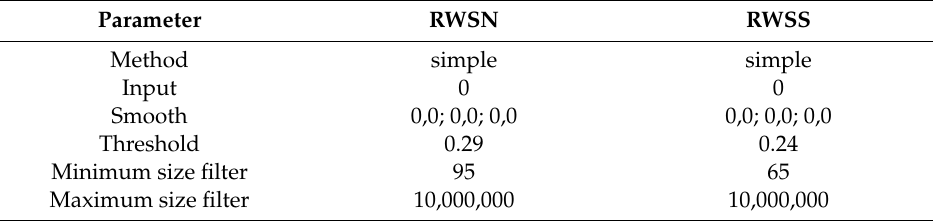
Table A3. Segmentation parameters for second segmentation with